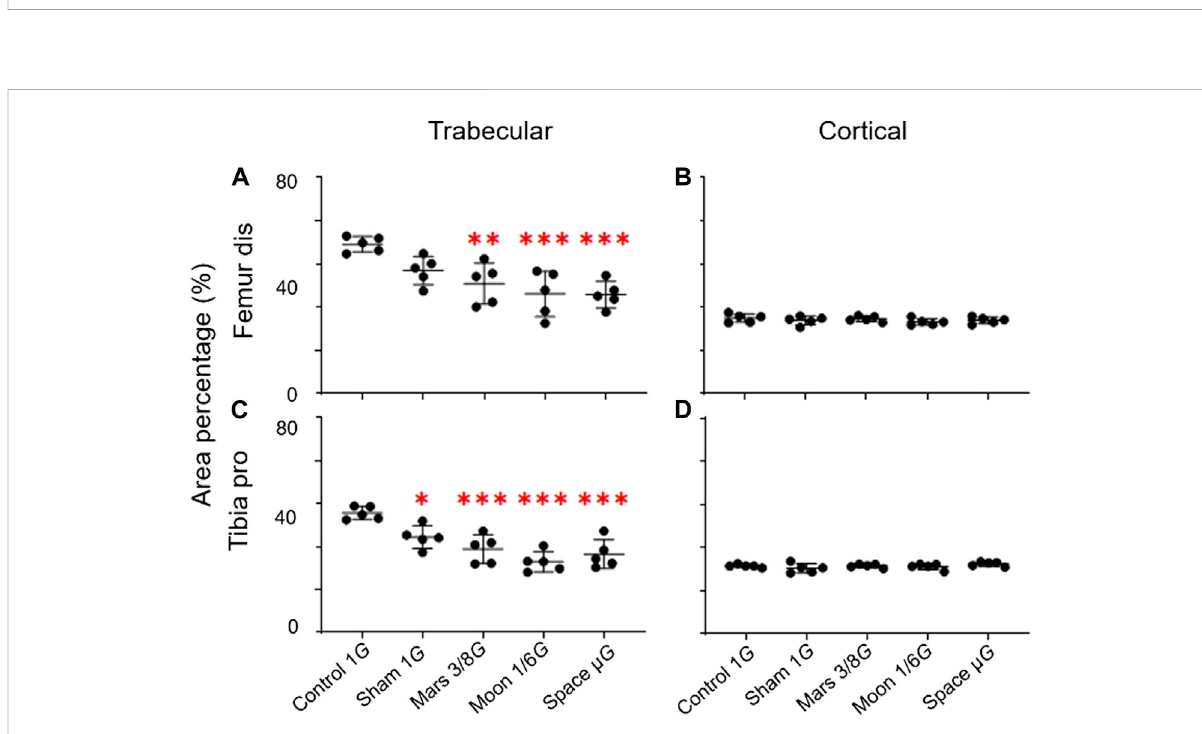
FIGURE 4 Areapercentageofthetrabecularand cortical boneinthedistalfemur andproximaltibia. (A) Trabecular areapercentageinthedistalfemur, (B) cortical area percentage in the distal femur, (C) trabecular area percentage in the proximal tibia, and (D) cortical area percentage in the proximal (mean ± SD, * p < 0.05 vs. control group, ** p < 0.01 vs. control group, *** p < 0.001 vs. control group, one-way analysis of